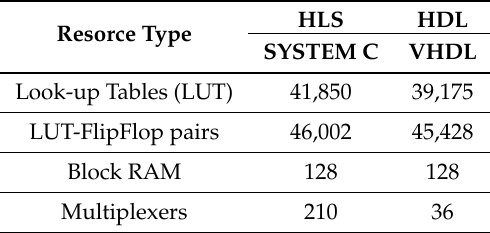
Table 2. Resource utilization for 128